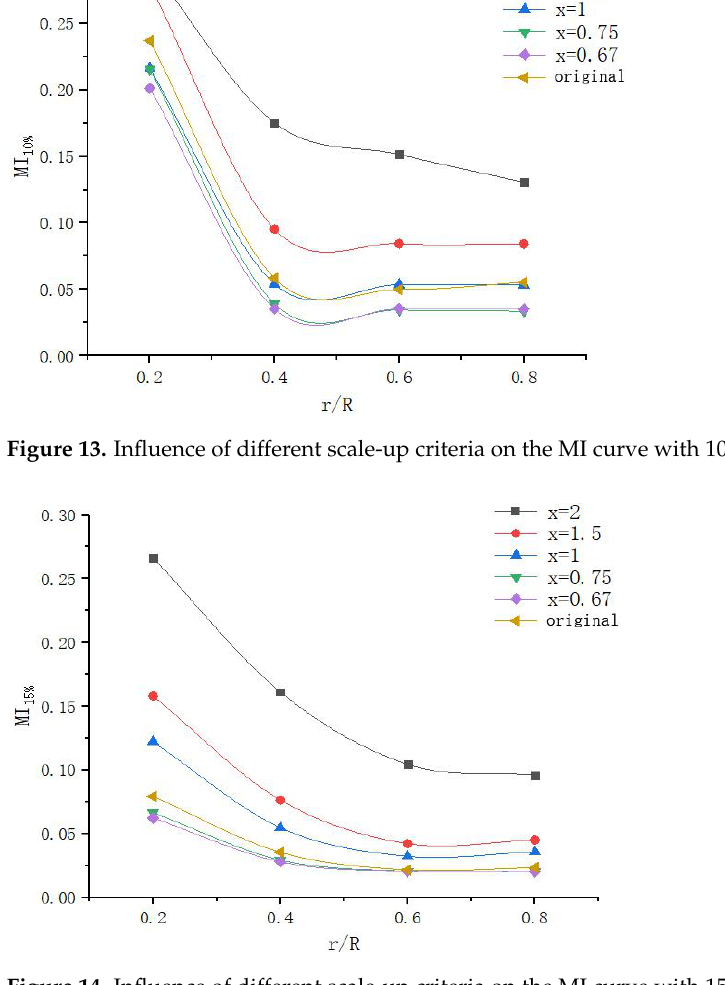
Figure 14. Influence of different scale-up criteria on the MI curve with 15% solid volume fraction.